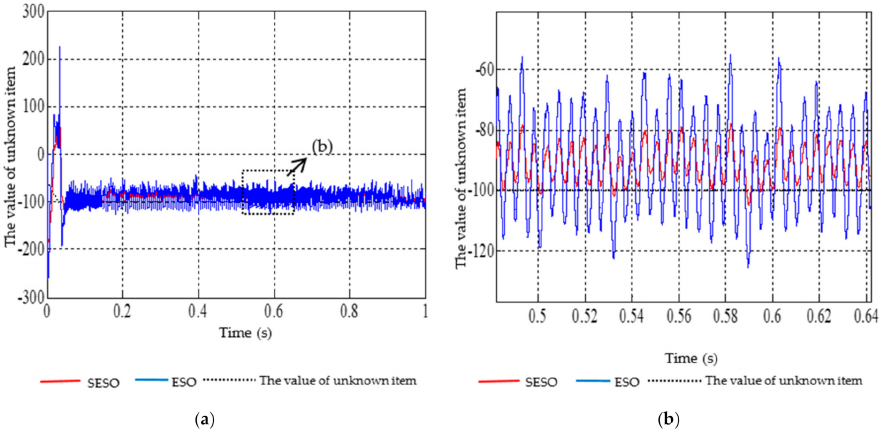
Figure 3. ( a ) Estimated value curves of the unknown item under the improved SESO and the traditional ESO; ( b ) Detailed view of the image ( a